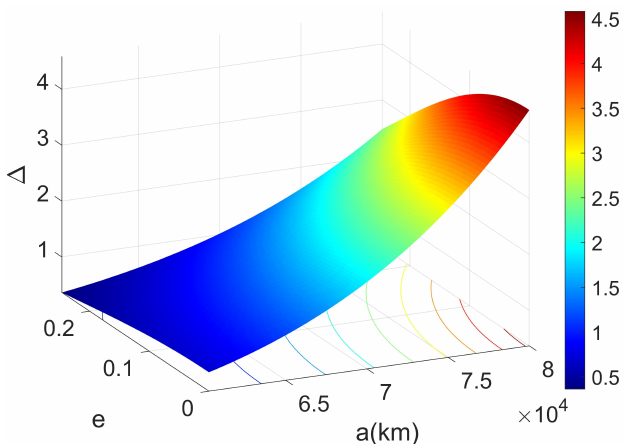
Figure 1. The discriminant of sun-synchronous orbits for different values of semimajor axis and